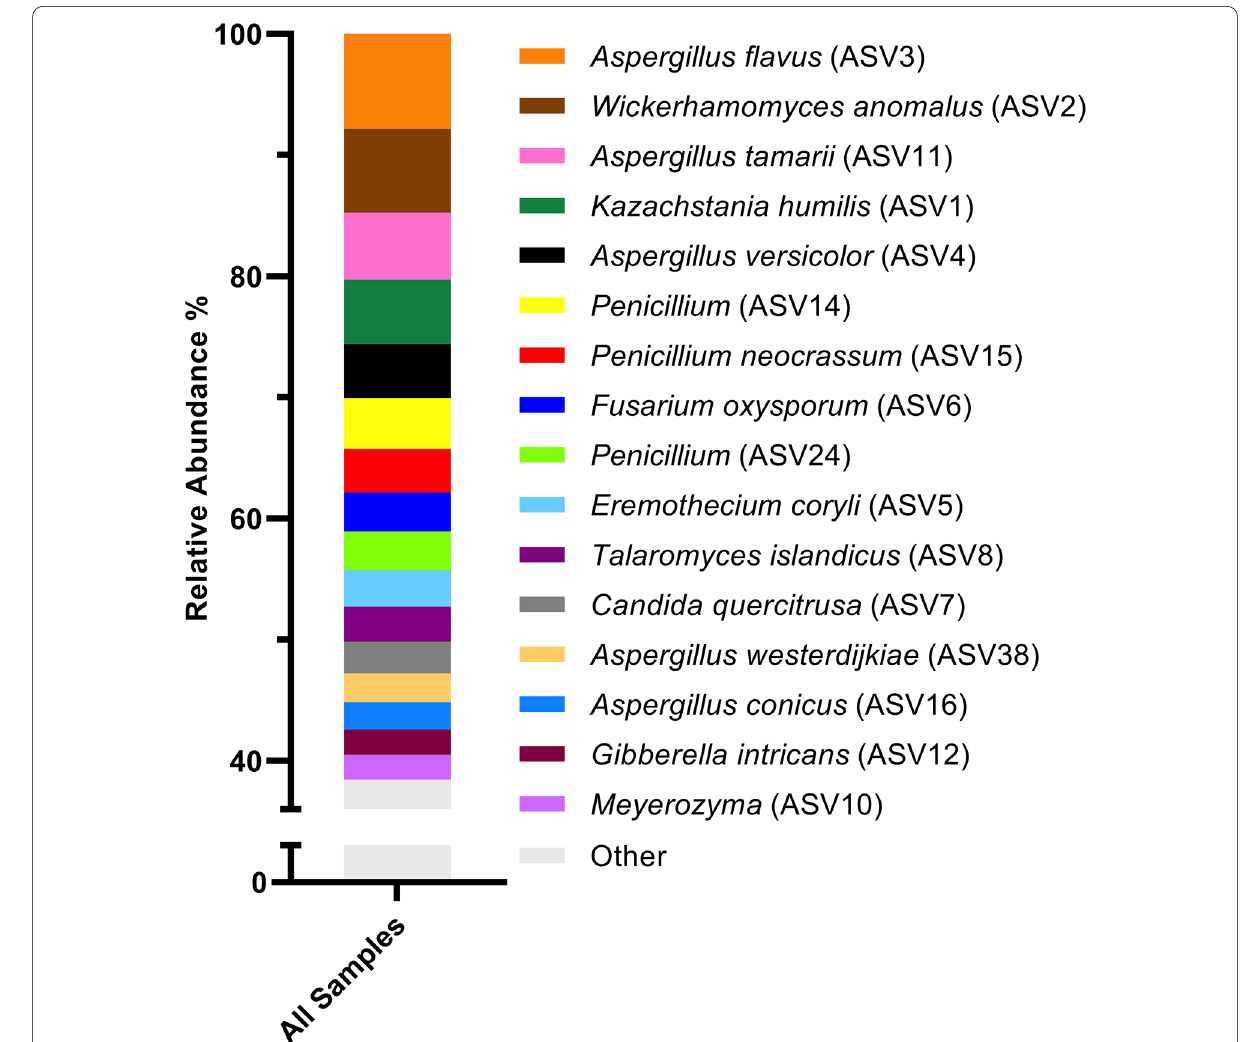
Fig. 1 Abundant fungi in raw coffee beans from Rwanda. An Illumina‑based sequence analysis of the fungal rRNA ITS region was used to determine the average relative abundances of ASVs (n 24). ASV numbers are indicated in =